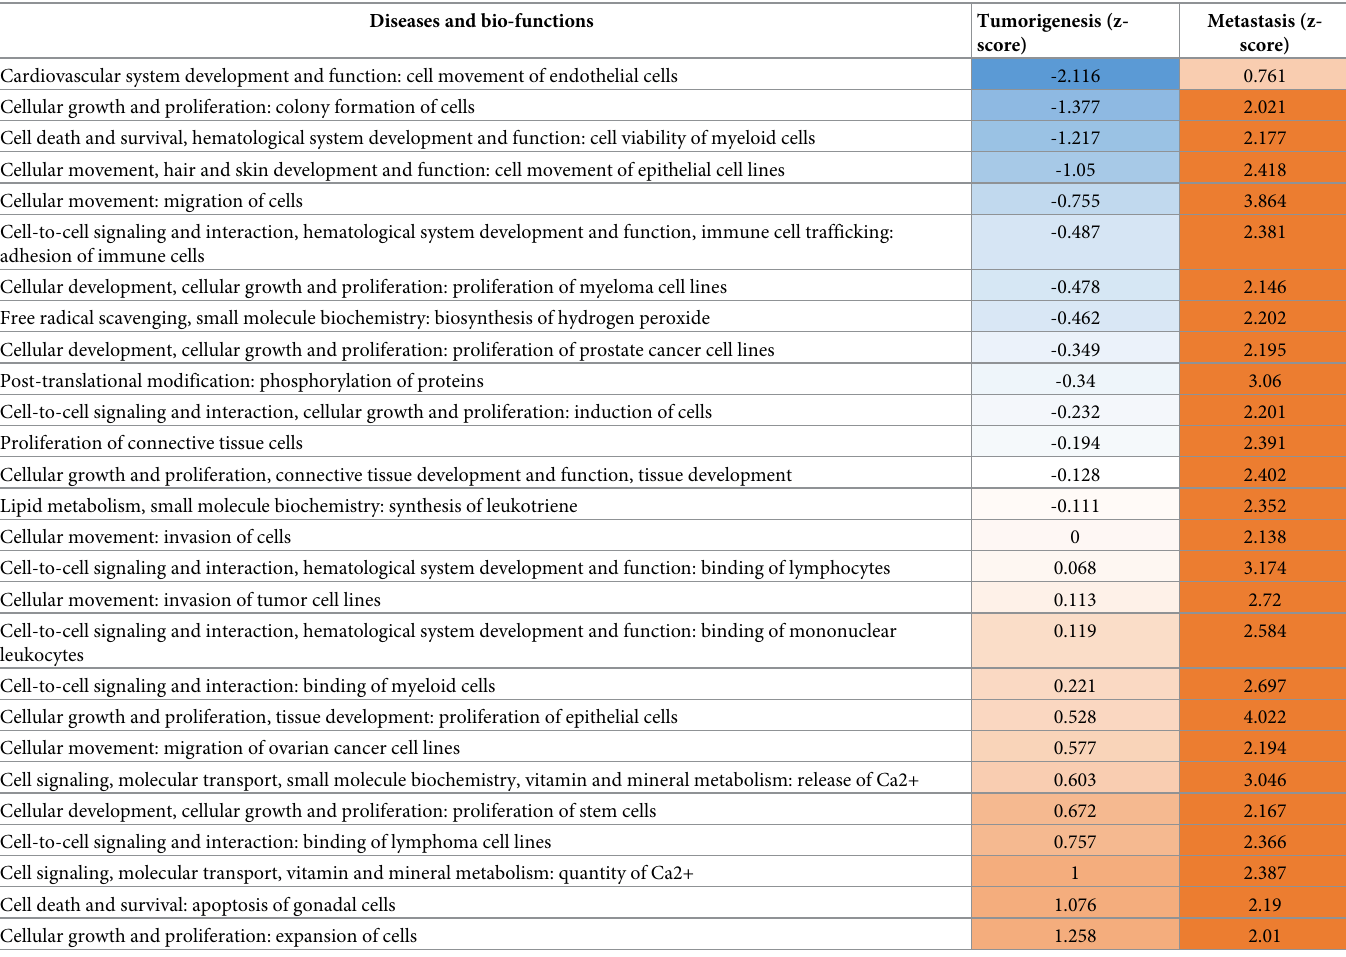
Table 2. Diseases and bio-functions of the intersecting PAN-ECM genes associated with differential expressions in tumorigenesis and metastasis of EC. Diseases and